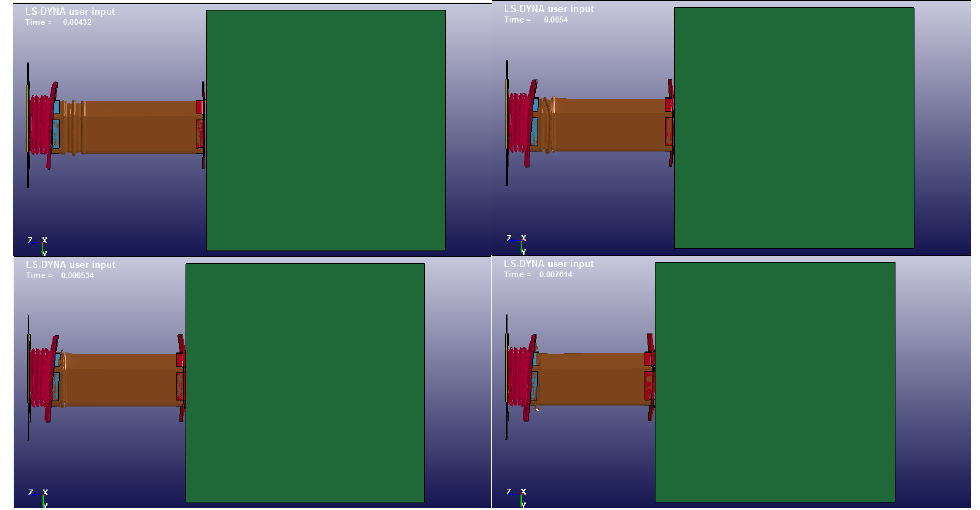
Figure 13. Time evolution of crash box, flanges and frame rail.